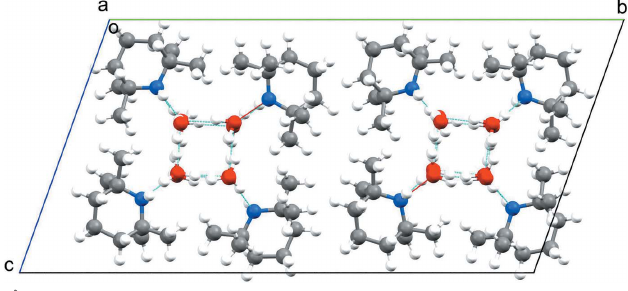
Figure 4 Structure of the water–TMP complex at 10 K from neutron-diffraction data, viewed down the a crystallographic axis, showing the two water channels.